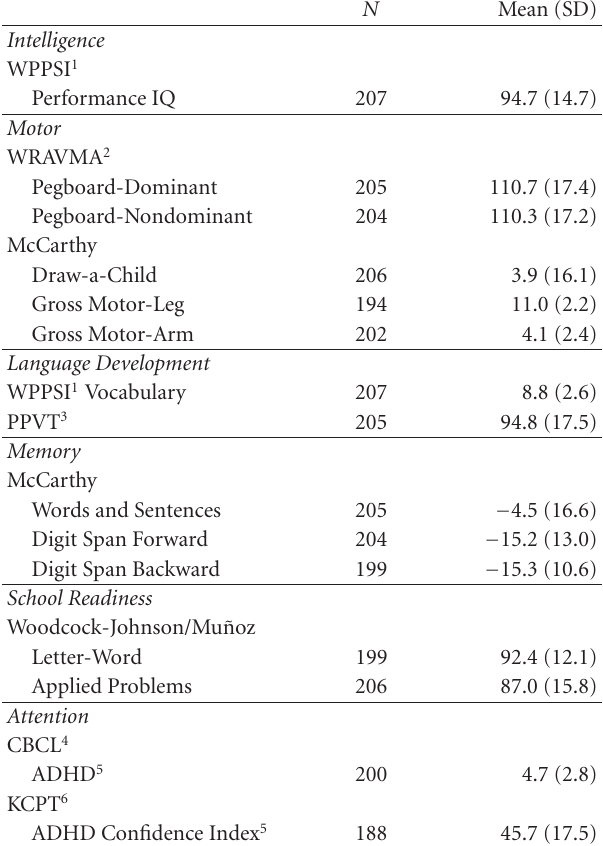
Table 3: Mean scores on neurodevelopmental scales at 5 years